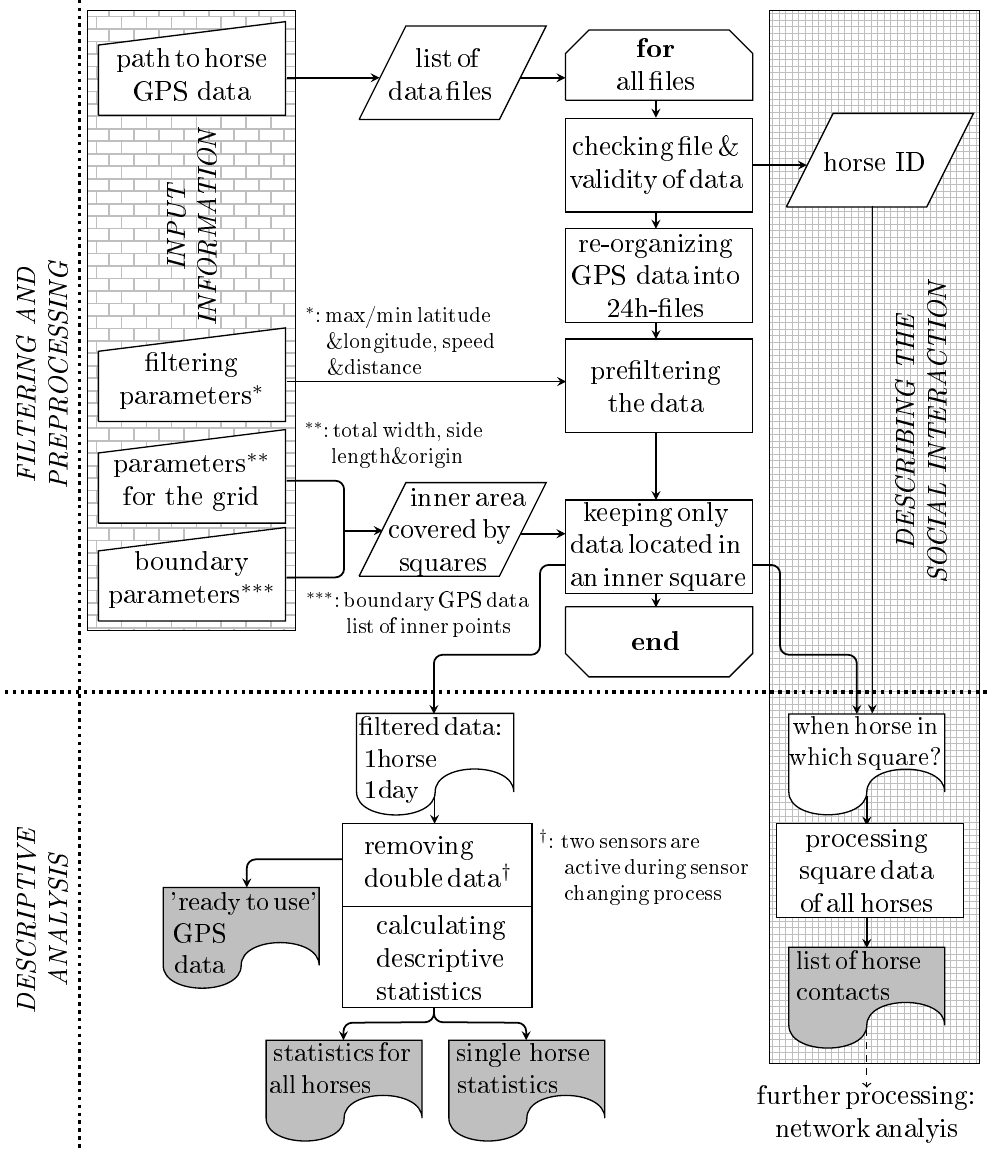
Figure 1. Flow chart of “HerdGPS-Preprocessor”. Above the dotted line the part of the program that prepares and filters the data is illustrated. In the part presented beneath the dotted line the preprocessed data is used for descriptive purposes. The roughly gridded box on the left contains all manually given input information. Each data file—possibly containing GPS data from several days—is processed individually, whereby the held data is reorganized to generate one file per horse and day. For the main filtering a grid is lain over the observation area and only GPS data from inside the grid squares is kept. With this, also the information which horse is when in which square is written to file. The finely gridded box on the right contains all stages towards a full description of the social interactions between the horses. The output documents are marked in